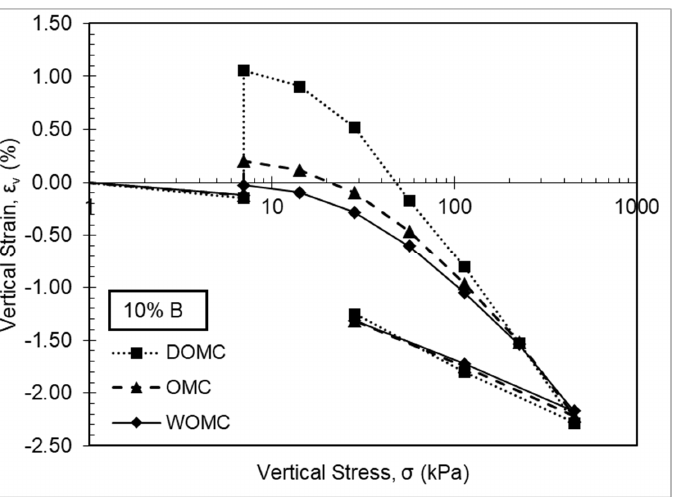
Figure 8. Consolidation tests for compacted 10% bentonite clay–sand mixture with three moisture contents. Appl. Sci. 2022 , 12 , x FOR PEER REVIEW 13 of 20